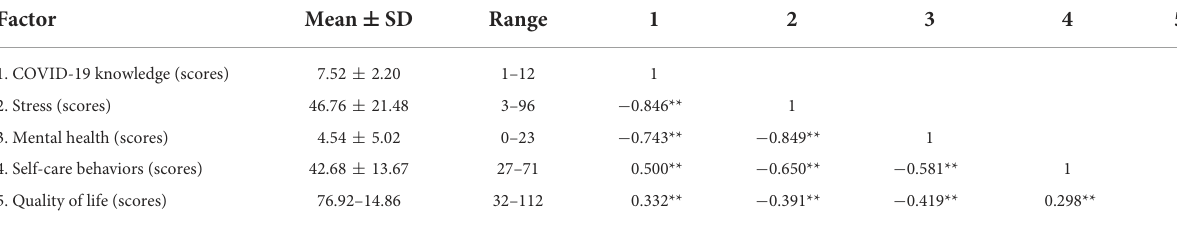
TABLE 2 Correlation between COVID-19 knowledge, stress, mental health, self-care behaviors, and quality of life among elderly patients with non-communicable diseases. Factor Mean ±